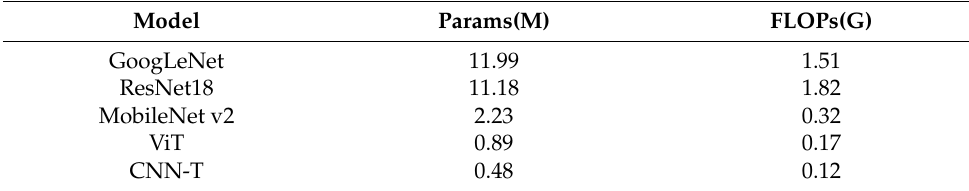
Table 4. Comparison of models parameters and